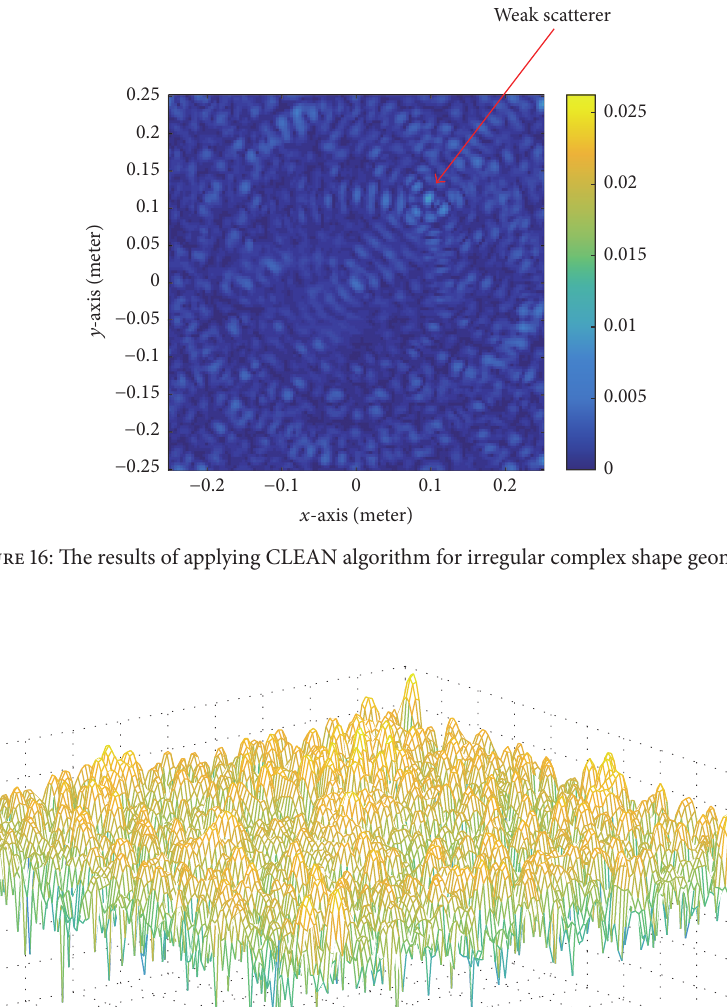
at 𝑧 = 0 . The domain has extended 12 cylinders placed in L-shape on the measurement domain creating complex target geometry. The extended 12 cylinders are equally spaced with distance 2𝜆 . These cylinders have radius of 𝜆/3 and a length of 0.05 m. The weak scatterer has radius of 𝜆/6 (83% larger than the weak scatterer in previous numerical results) and located at coordinate (0.2 m, 0.223 m) in the 𝑥𝑦 - plane with length 0.1 m. The noise in the numerical model occurs from two sources. First source is the multipath effects (interaction between the scatterers); the second noise source was added to the scattering field vector with different mean and variance than the received scattering field. The initial tomographic image of contrast function is shown Figure